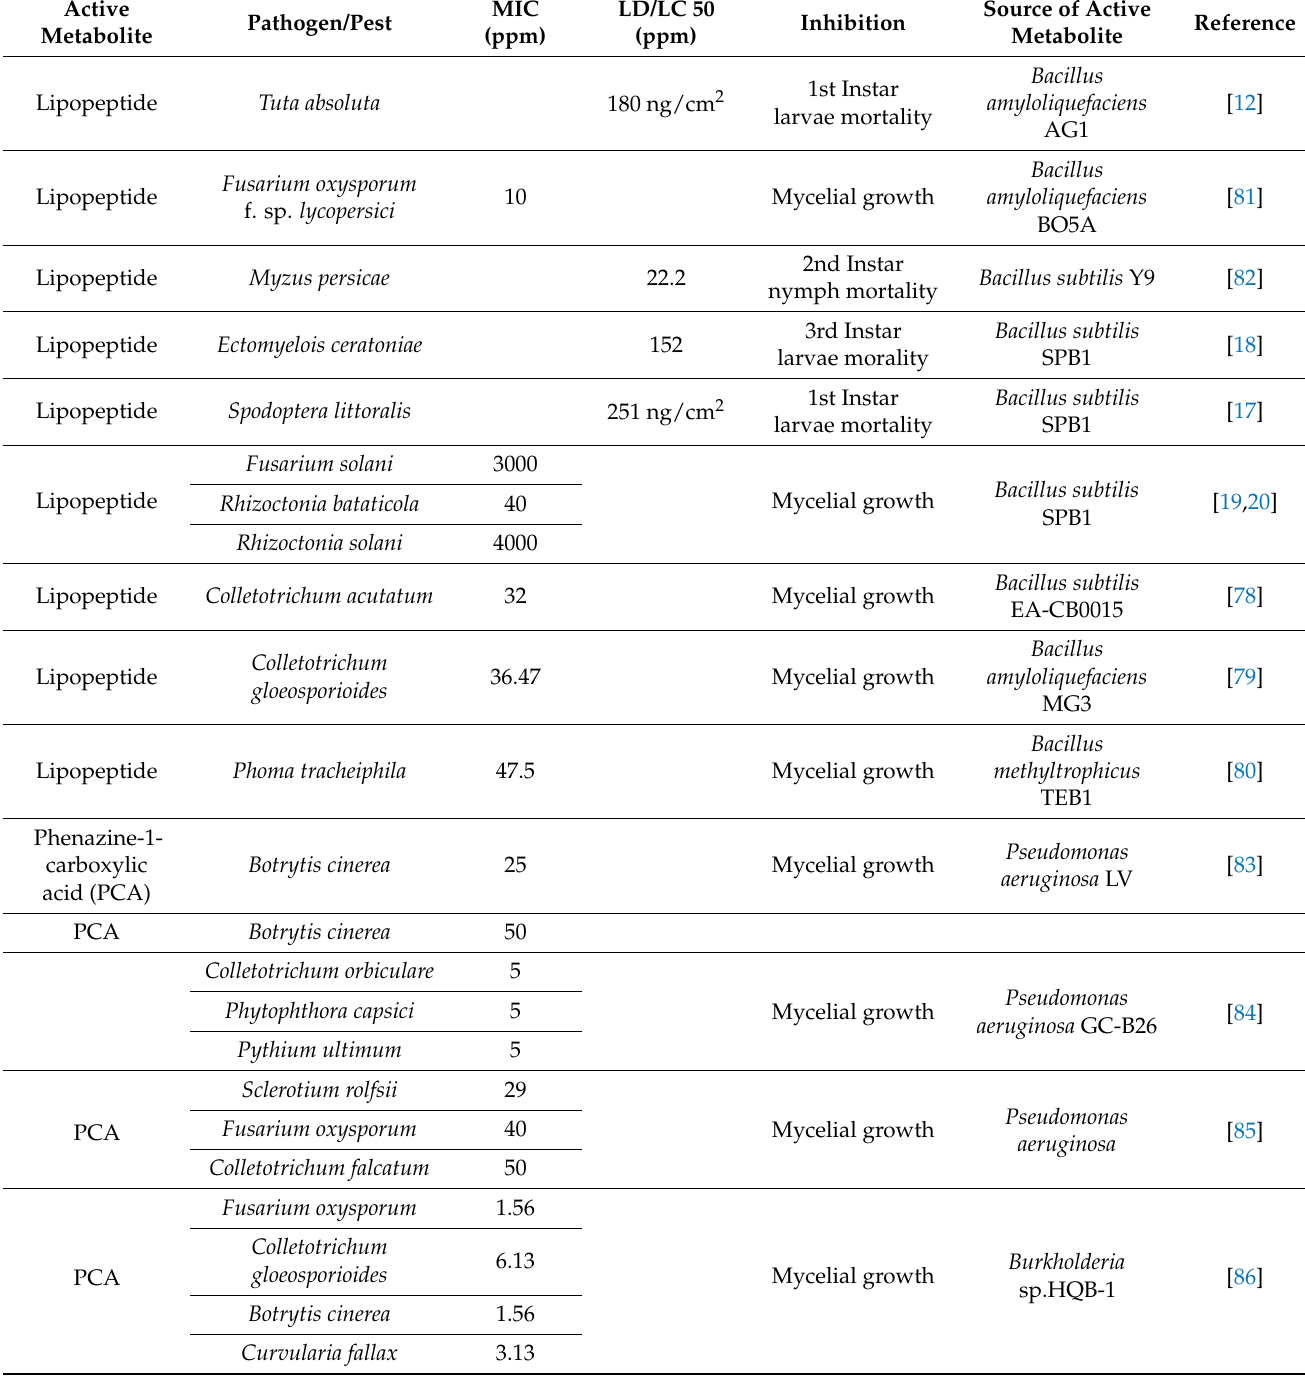
Table 2. Minimum inhibitory concentration (MIC) and lethal dose (LD)/lethal concentration (LC) 50 of secondary metabolites from microbials against fungal pathogens; lethal dose or concentration against pathogenic insects or